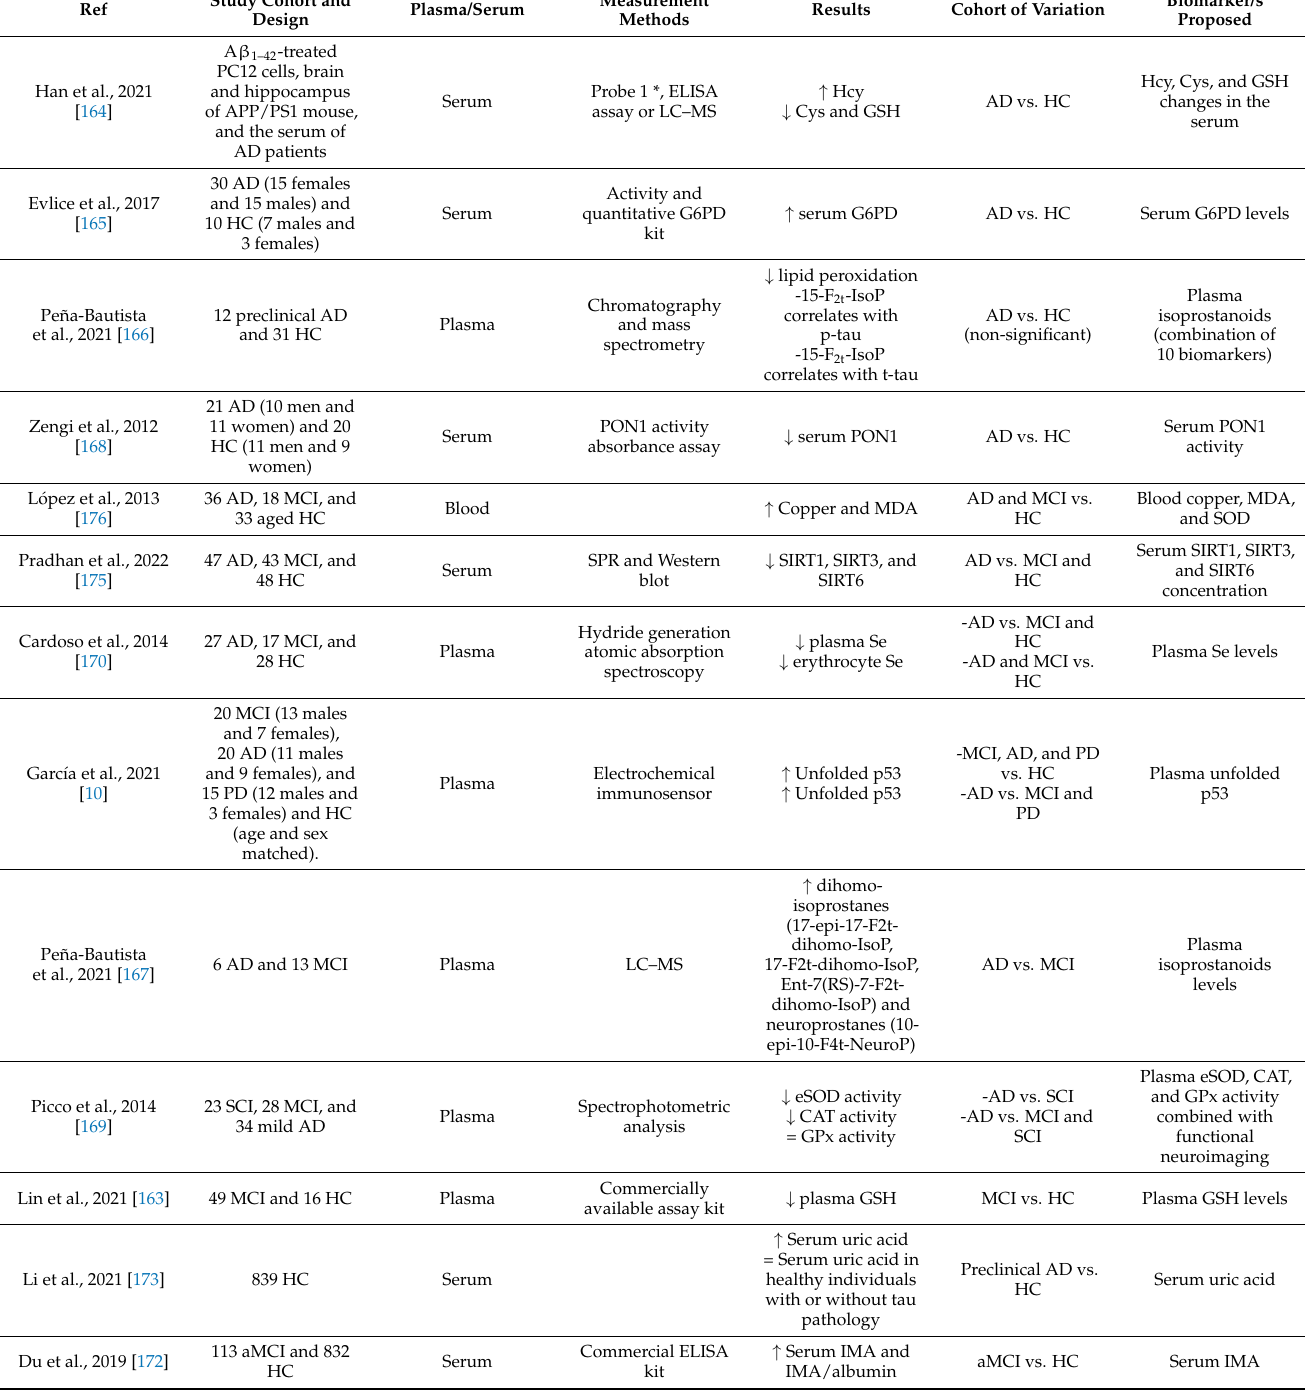
Table 1. Oxidative-stress-related blood AD